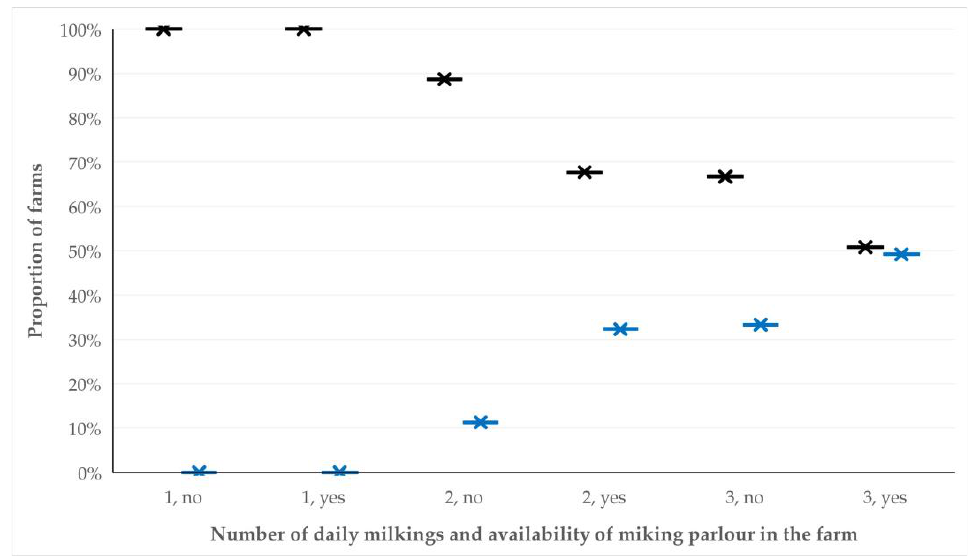
Figure 2. Proportions of small ruminant farms (sheep flocks and goat herds cumulatively) in Greece, in which reproductive control was (blue) or was not (gray) applied, in accord with the number of daily milkings and the availability of milking parlour in the farms.